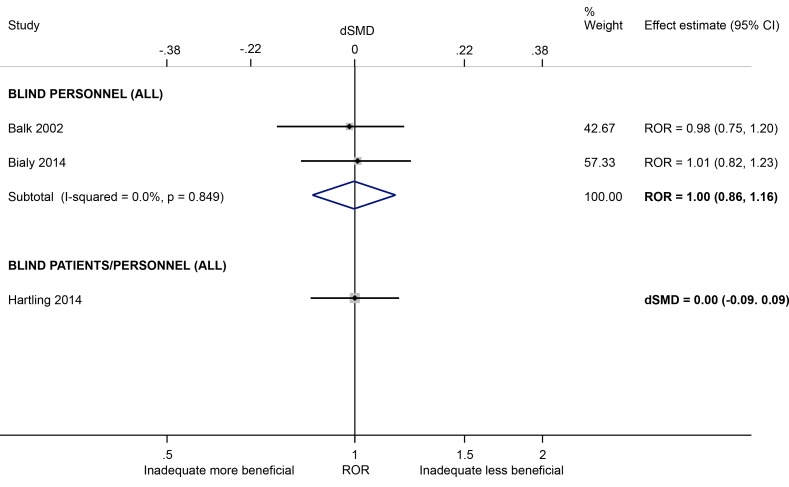
Random-effects meta-analysis of RORs and dSMDs associated with lack of/unclear blinding of personnel or participants/personnel (versus blinding of either party).